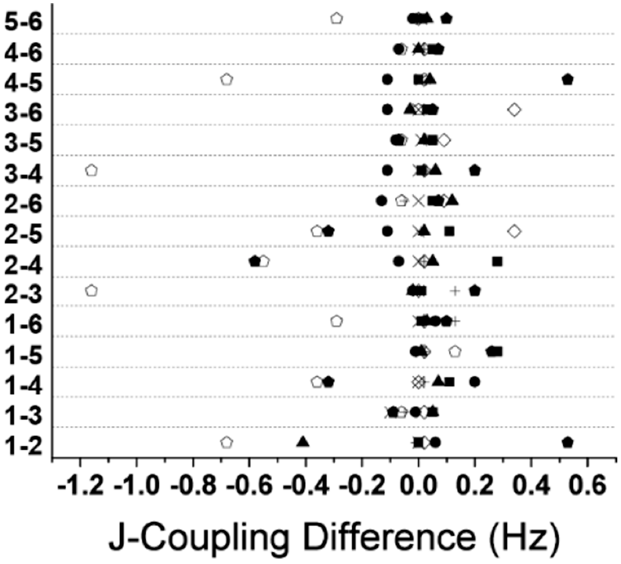
Figure 5. Differences in the J -couplings between the JCS and the literature values reported in [44] and [45]. The symbols correspond to different compounds (● monofluorobenzene, + 1,2 difluorobenzene, × 1,3-difluorobenzene, ◇ 1,4- difluorobenzene, ▲ 1,2,4- trifluorobenzene, ■ 1,2,4,5- tetrafluorobenzene, and ⬟ and ⌂ for pentafluorobenzene). The values on the y -axis correspond to the coupled positions on the benzene ring.